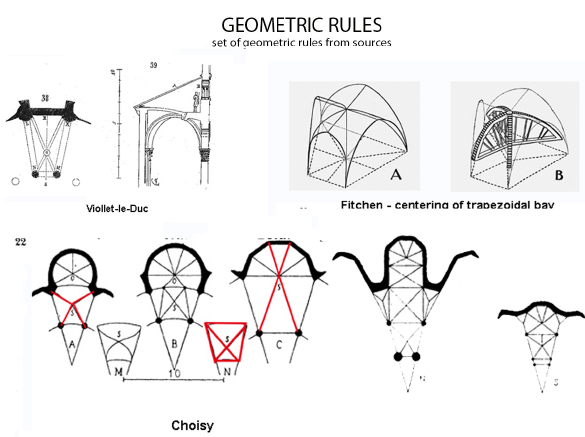
Figure 2 : trapezoidal vault tracing: different geometric rules for plan tracing from